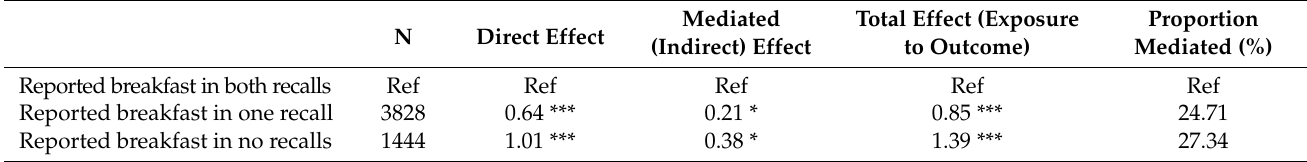
Table 3. Mediation effect of the DII on the association between reported breakfast and BMI. Mediated Total Effect (Exposure N Direct Effect (Indirect) Effect to Outcome)